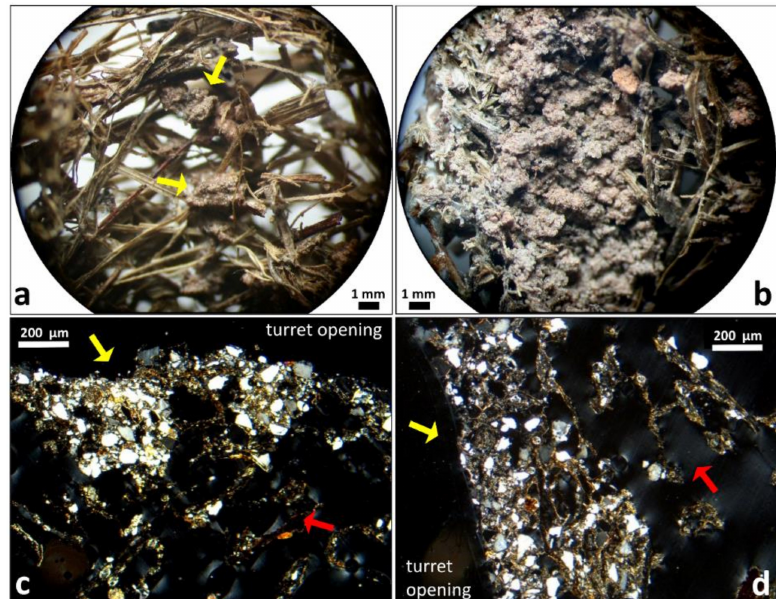
Figure 3. Examples of lining fabrics of the internal turret wall. ( a ) Open fabric as observed in the uppermost internal part of the turret, with the occurrence of a few soil pellets (yellow arrows) lined between vegetal fibers. ( b ) Close fabric with a continuous pelletal lining covering all fibers of the internal wall, as observed at the turret base. ( c ) Thin section showing an example of an undulated lining (yellow arrow) on the inside wall of the turret and the location of the turret opening. Two aggregates of sand grains cemented with clay are visible. The red arrow points at the porous turret wall. ( d ) Thin section showing a wider, compact, and continuous lining (yellow arrow) on the inside wall of the turret opening, and the adjacent turret wall (red arrow). Photo credits: M. I.